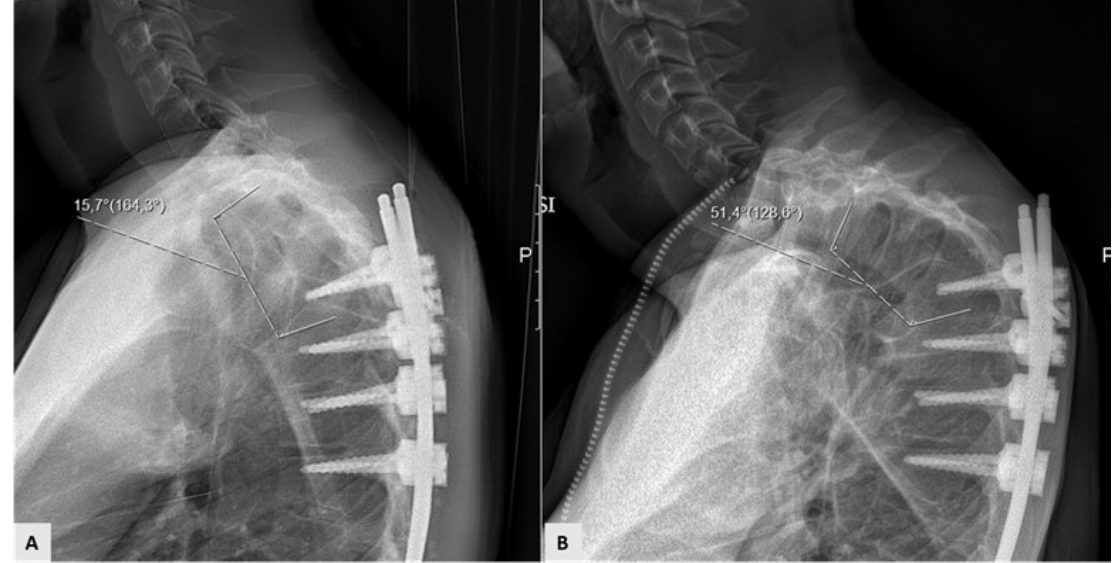
Figure 1. Example of proximal junctional kyphosis; ( A ) early postoperative proximal junctional angle; ( B ) 4-month increase (>10°) in kyphosis between the upper instrumented vertebra—UIV— and two vertebrae above UIV.